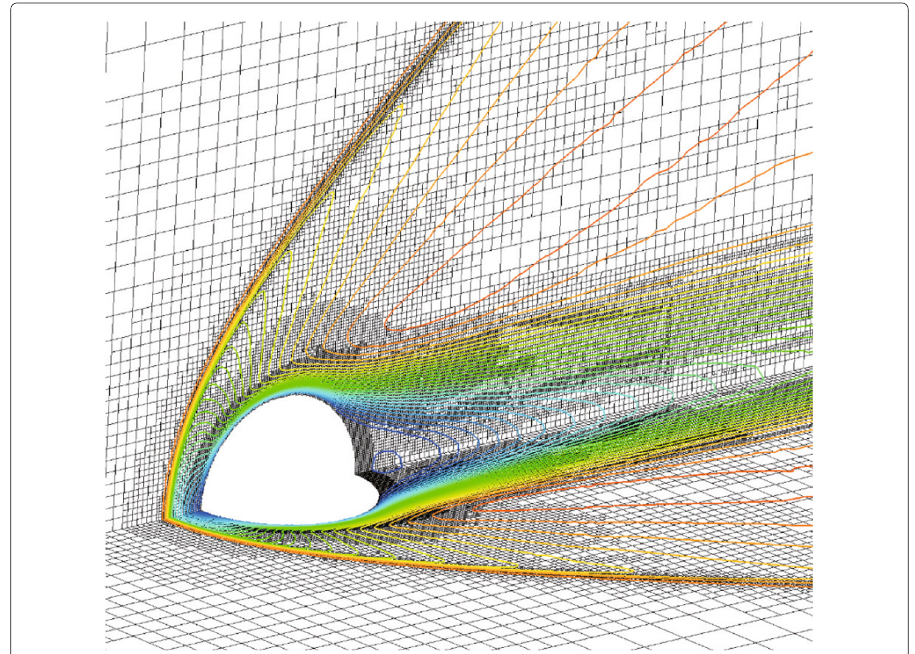
Fig. 28 The adaptive grids and Mach contours on two